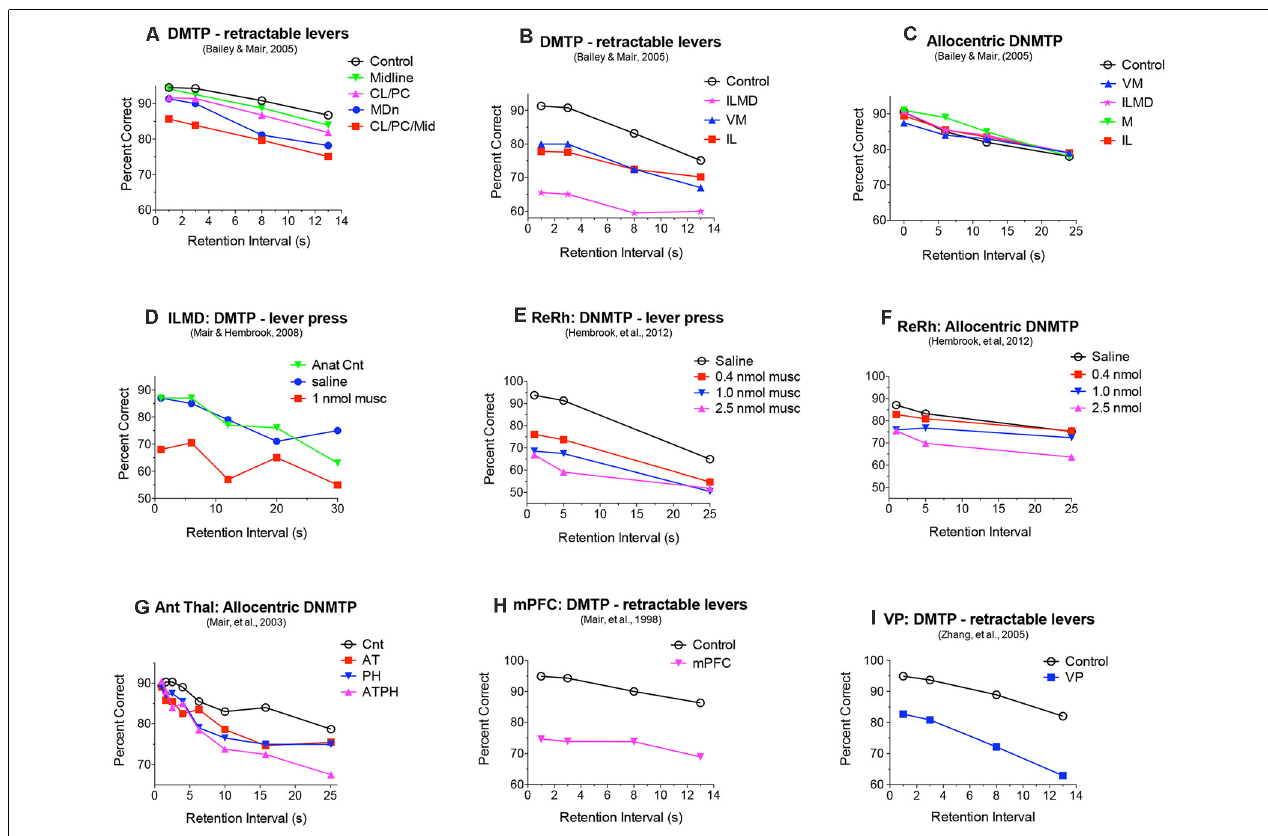
FIGURE 4 | Effects of central thalamic lesions on delayed matching (DMTP) and non-matching (DNMTP) to position accuracy. Lesions of the mediodorsal nucleus (MD) produced delay-dependent (A) and lesions of rostral intralaminar (IL), ventromedial (VM), and IL and MD combined (ILMD) produced delay-independent impairment (B) of egocentric DMTP trained with retractable levers, an impairment also observed with reversible inactivation of IL and MD (D) . IL, ILMD, and VM lesions did not have significant effects on allocentric radial maze DNMTP (C) . Reversible inactivation of reuniens (Re) and rhomboid (Rh) nuclei in the ventral midline thalamus produced delay-independent impairment of DNMTP trained with retractable levers at all muscimol doses tested (E) and allocentric radial maze DNMTP only at the highest dose tested (F) . Anterior thalamic (AT) lesions produced delay-dependent impairment of allocentric radial maze DNMTP comparable to the effects of parahippocampal cortex (PH) lesions (G) . Combined AT and PH lesions produced a larger deficit, comparable to the effects of hippocampal lesions Figure 2E on this task. Lesions of the medial prefrontal cortex (mPFC) and ventral pallidum (VP) produce delay-independent impairment of DMTP (H,I) comparable to the effects of IL, ILMD, and VM lesions (B) . Data are replotted from studies